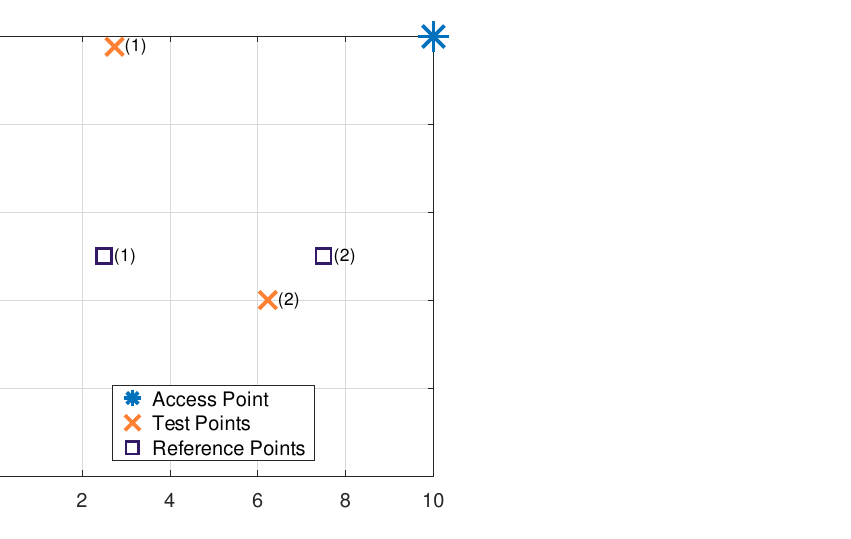
Figure 2. Example of scenario: 1 access point (AP), 2 reference points (RPs) and 2 test points.